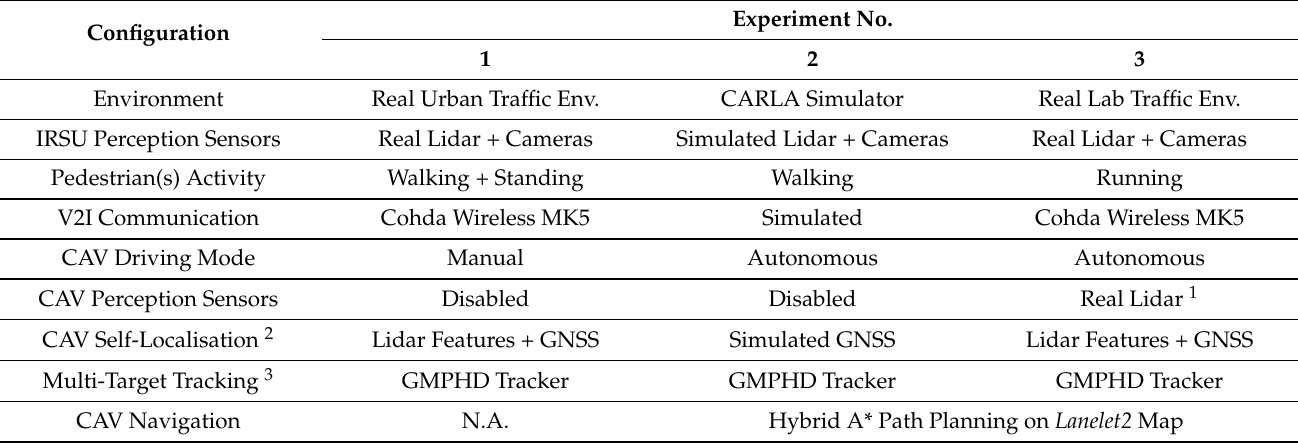
Table 2. An overview of experiment